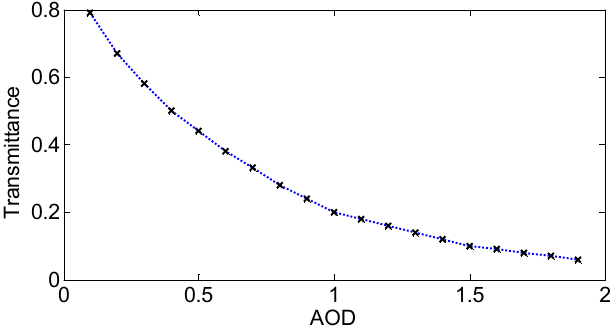
Figure 2. Relationship of Transmittance and AOD (aerosol optical depth) when solar zenith angle is 30 ◦ , sensor zenith angle is 60 ◦ and the relative azimuth angle between solar and sensor is 90 ◦